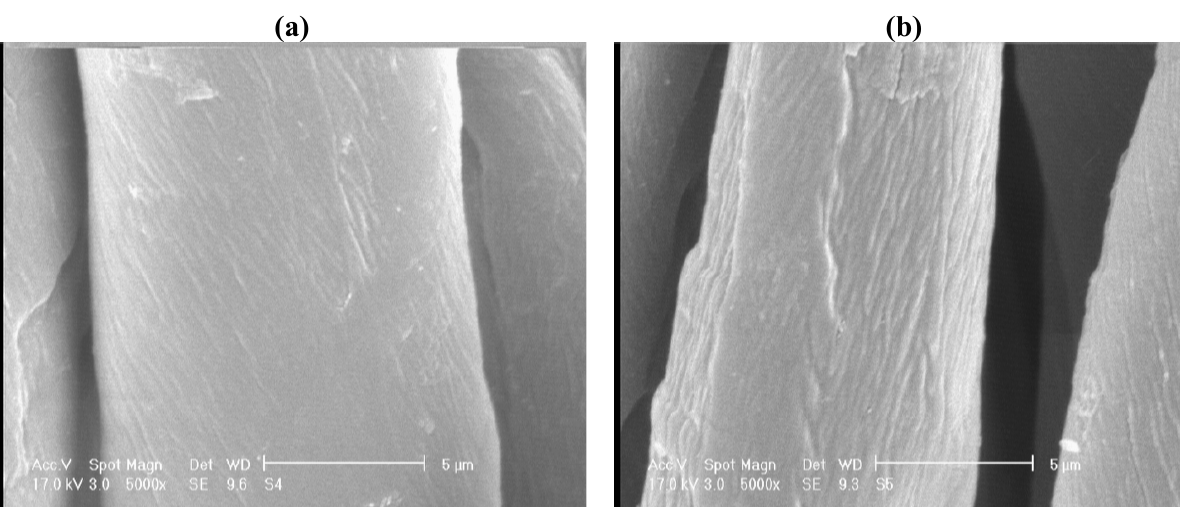
Figure 4. S canning electron microscopy (SEM) micrographs of ( a ) untreated cotton; ( b ) laser treated at 100W, 100cm/s, magnification of 5,000; ( c ) laser treated at 100 W, 100cm/s and magnification of